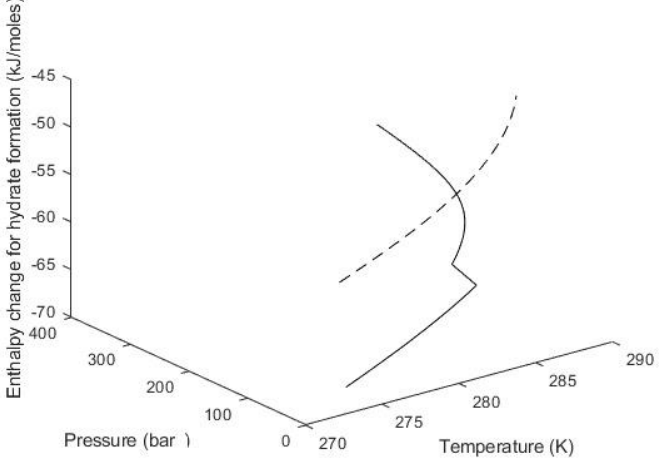
Figure 5. Enthalpy changes associated with hydrate formation along the hydrate P-T equilibrium curves for CO 2 hydrate (solid) and CH 4 hydrate (dashed). Units are kJ/mol hydrate former.